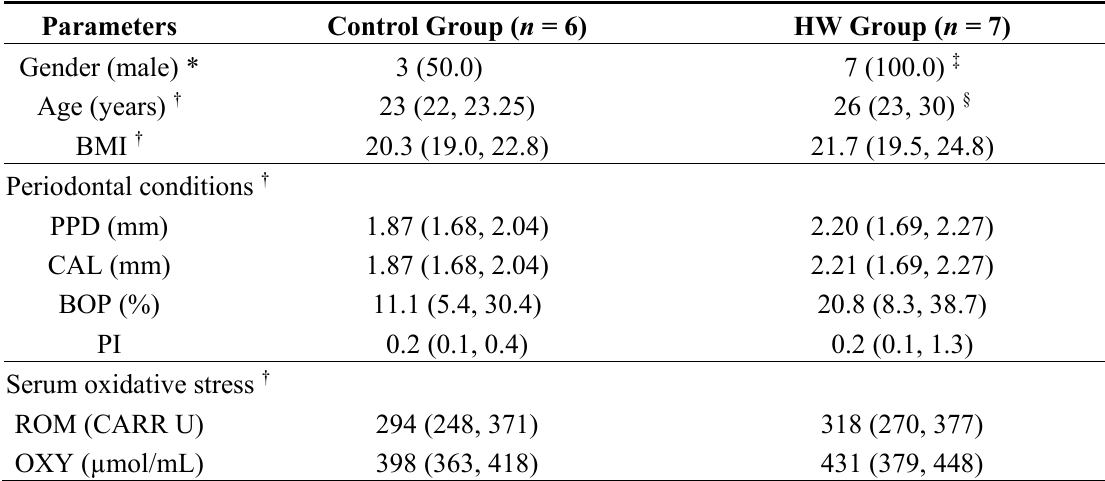
Table 1. Clinical and serum parameters at